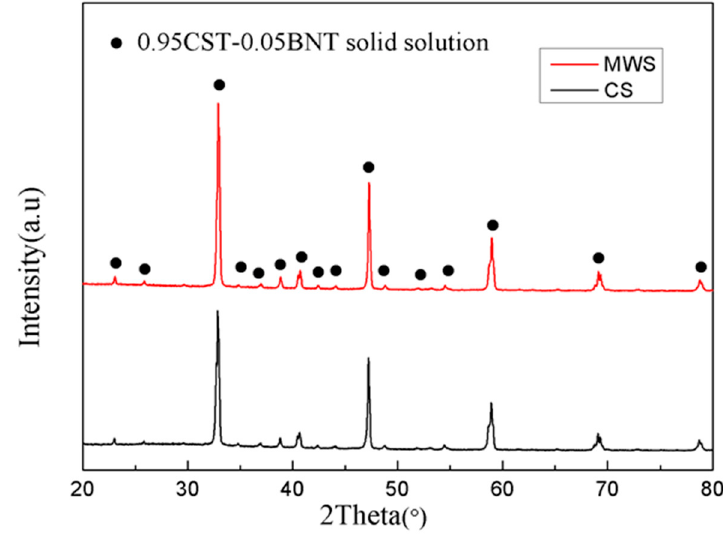
Figure 1. XRD patterns of 0.95CST–0.05BNT samples sintered by different methods.